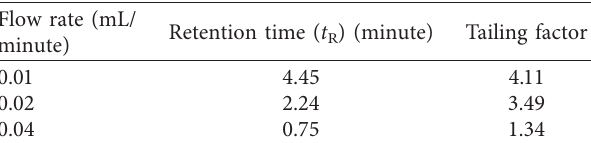
Figure 6: Effect of pH on the mobile phase towards the capacity factor. (Stationary phase: monolithic MIP 1 column; mobile phase: mixture of acetonitrile: (methanol: 0.05% TEA pH 3 (15 :85)) 1 :9 v/v). Table 5: Effect of flow rate variation on the retention time of atenolol.